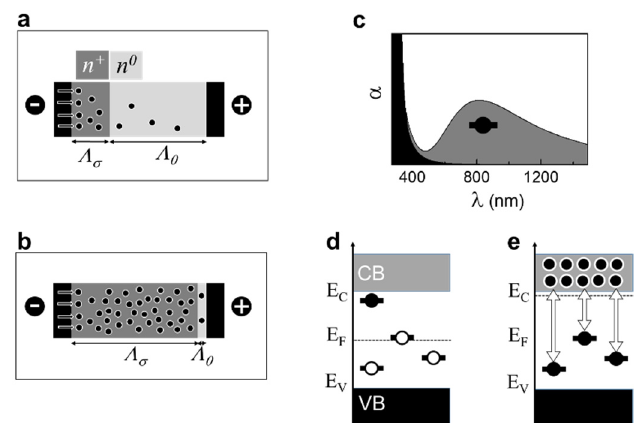
Figure 6. Electronic processes during DC degradation and coloration. ( a , b ) Schematics of carrier injection and transport during DC degradation. ( c ) Optical absorption and ( d , e ) schematics of ( d ) deep in-gap traps and ( e ) electronic relaxation to these traps.